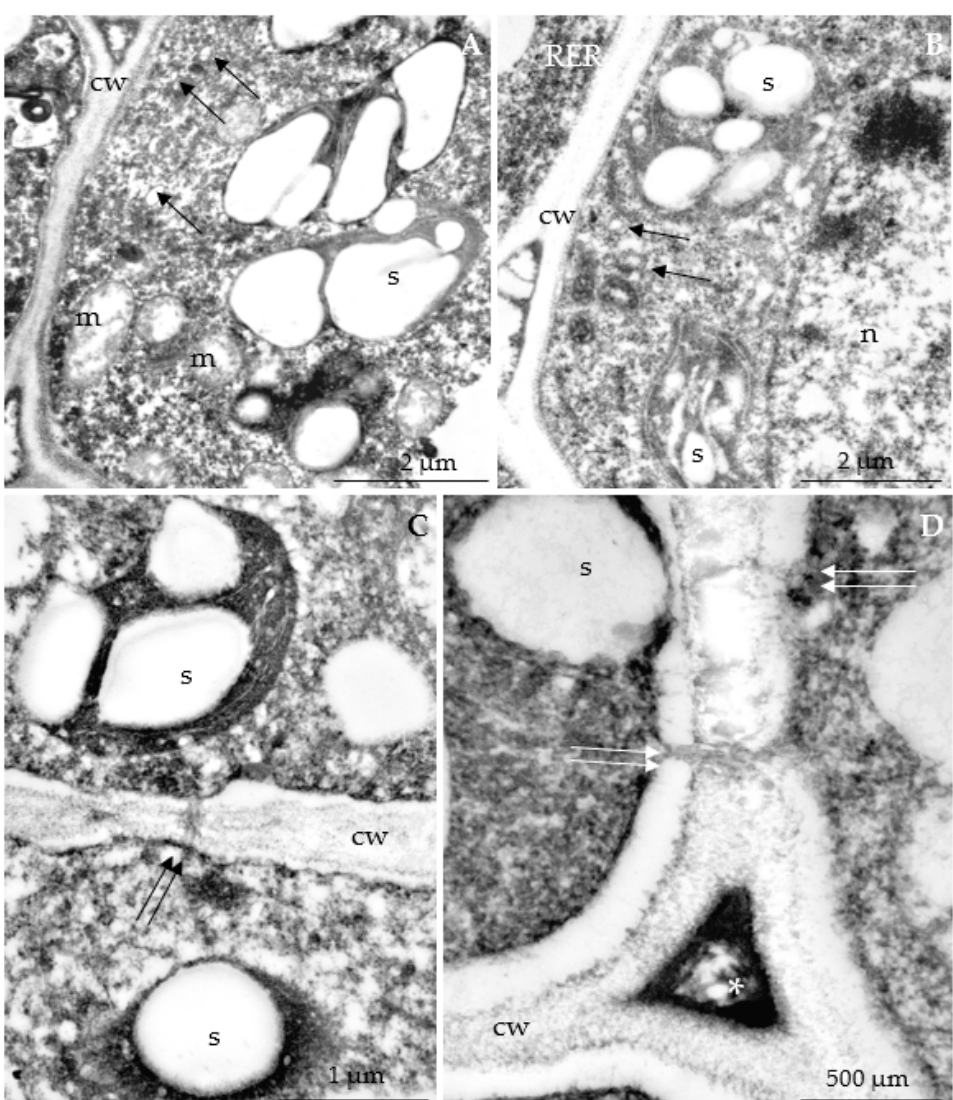
Figure 21. ( A – D ). Fragments of nectary epidermis ( A , D ) and parenchyma ( B , C ) cells in R. idaeus ‘Polka’ in the initial secretion phase. ( A , B ): amyloplasts with starch grains (s), transport vesicles (arrow), mitochondria (m) visible near the cell wall (cw) (micrograph A), nucleus (n) with a nucleolus and rough endoplasmic reticulum (RER) (micrograph ( B )). ( C , D ): cell wall (cw), starch grains (s) in plastids, plasmodesma (two arrows), dark material in intercellular space (asterisk) (micrograph ( D )).